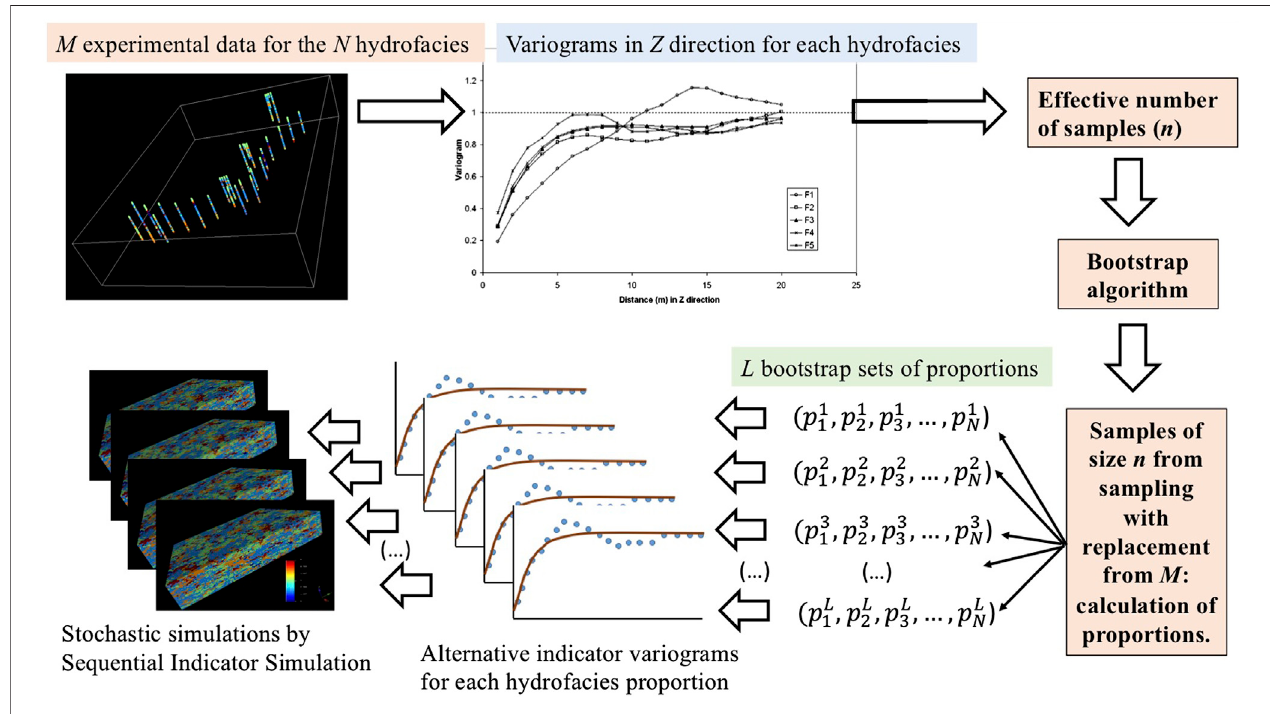
FIGURE 1 | Flowchart for the proposed